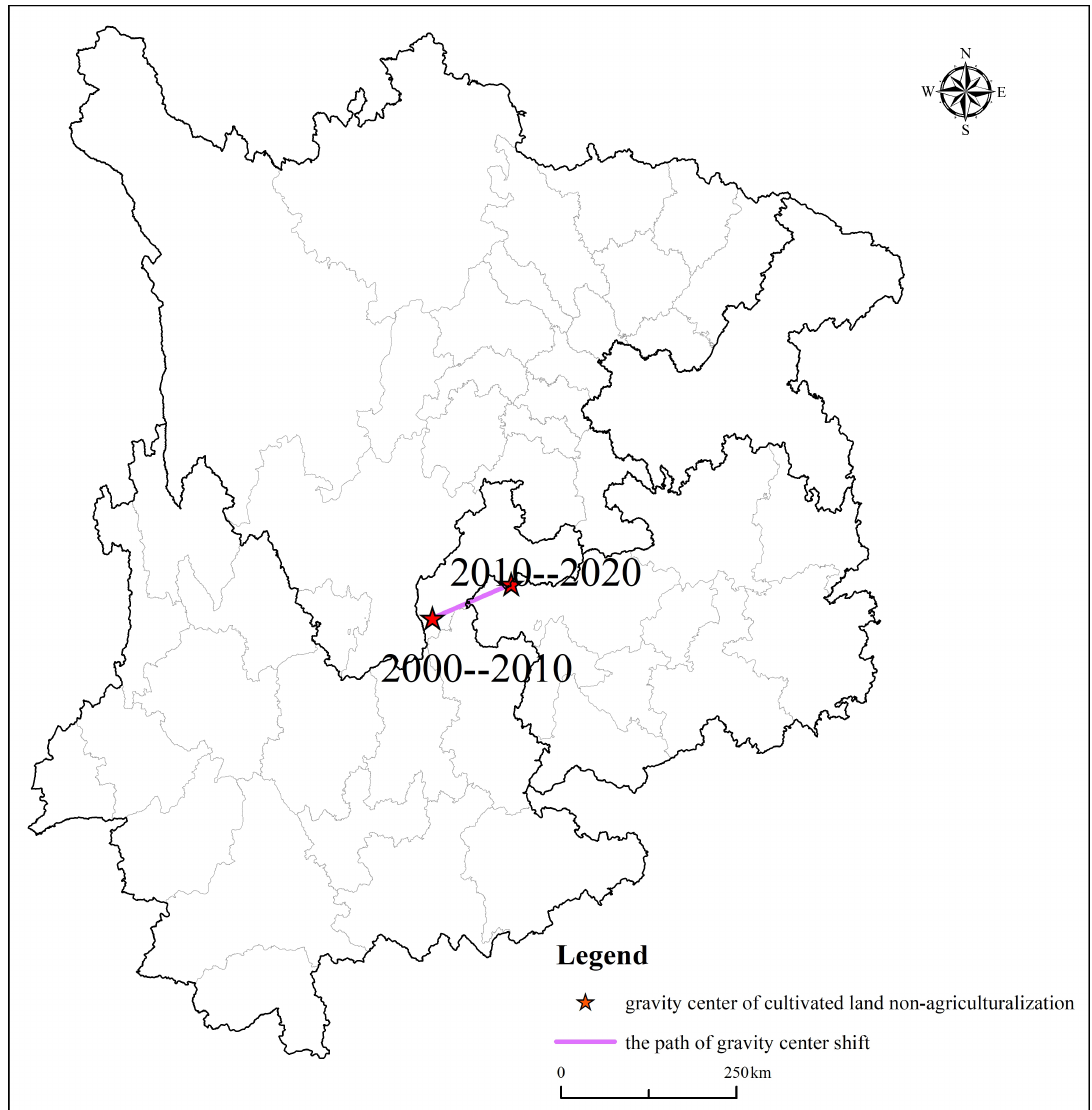
Figure 6. The pathway of non-agricultural gravity shift of cultivated